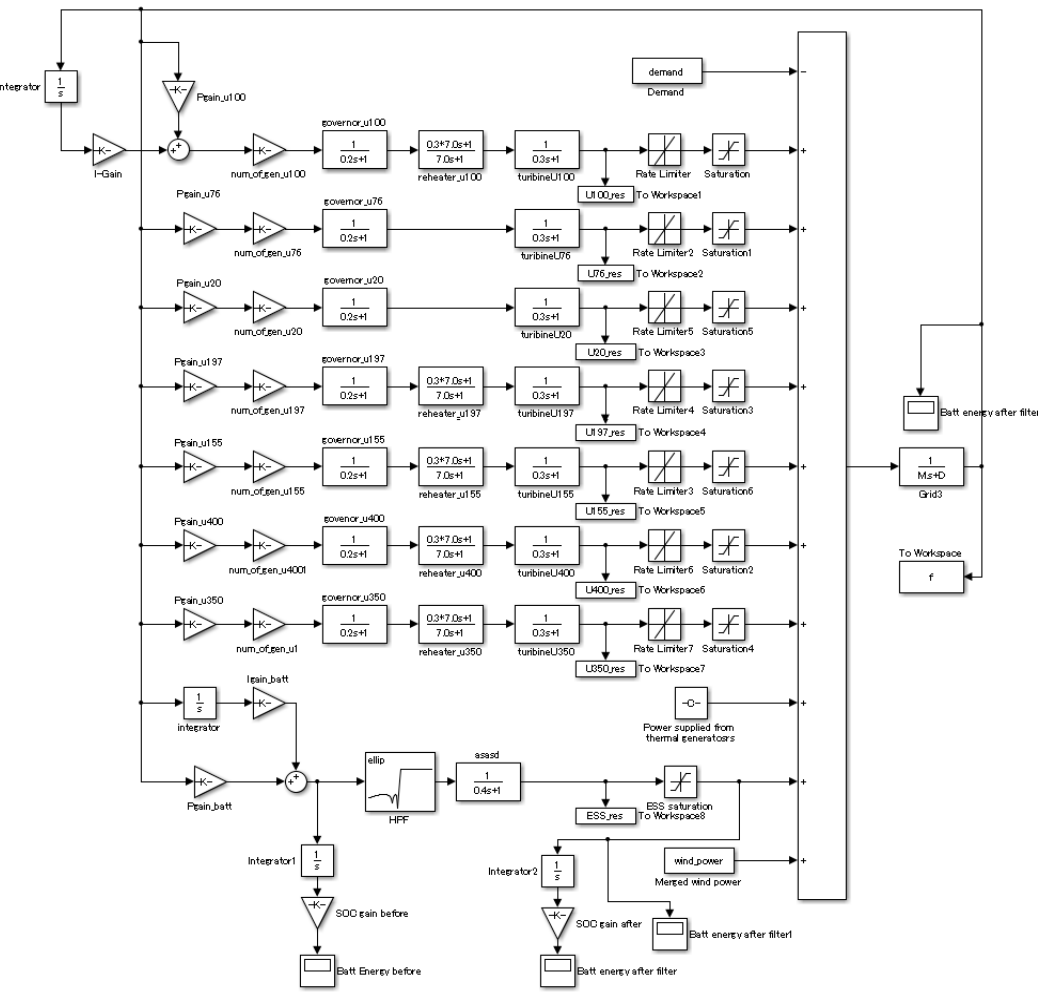
Figure 6. Frequency analysis model. Reproduced with permission from [32]. IEEE, 2016.